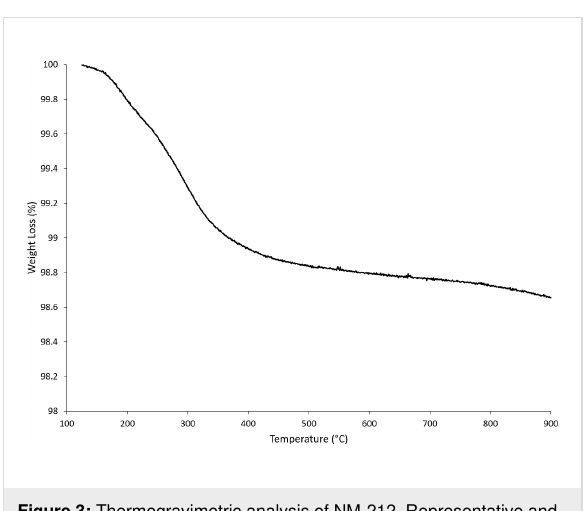
Figure 3: Thermogravimetric analysis of NM-212. Representative and near average of three determinations.